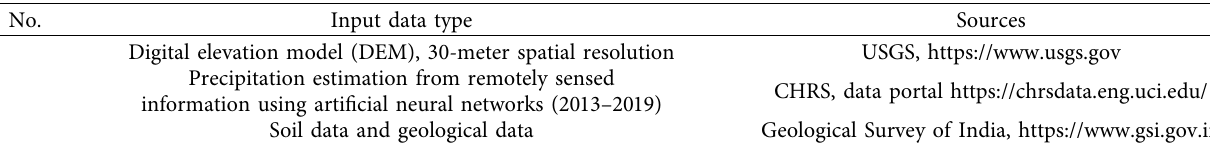
Figure 1: The location of the study area. Table 1: Types of input data and their sources.